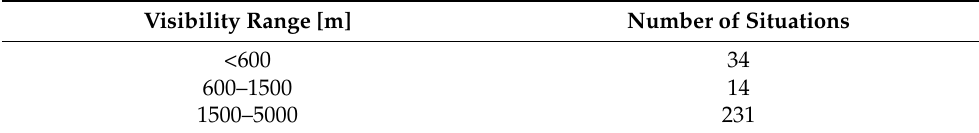
Table 9. Results of the extended validation experiment for assessing the accuracy of the visibility by the proposed system at LZTT in the period of September 2018–April 2019.